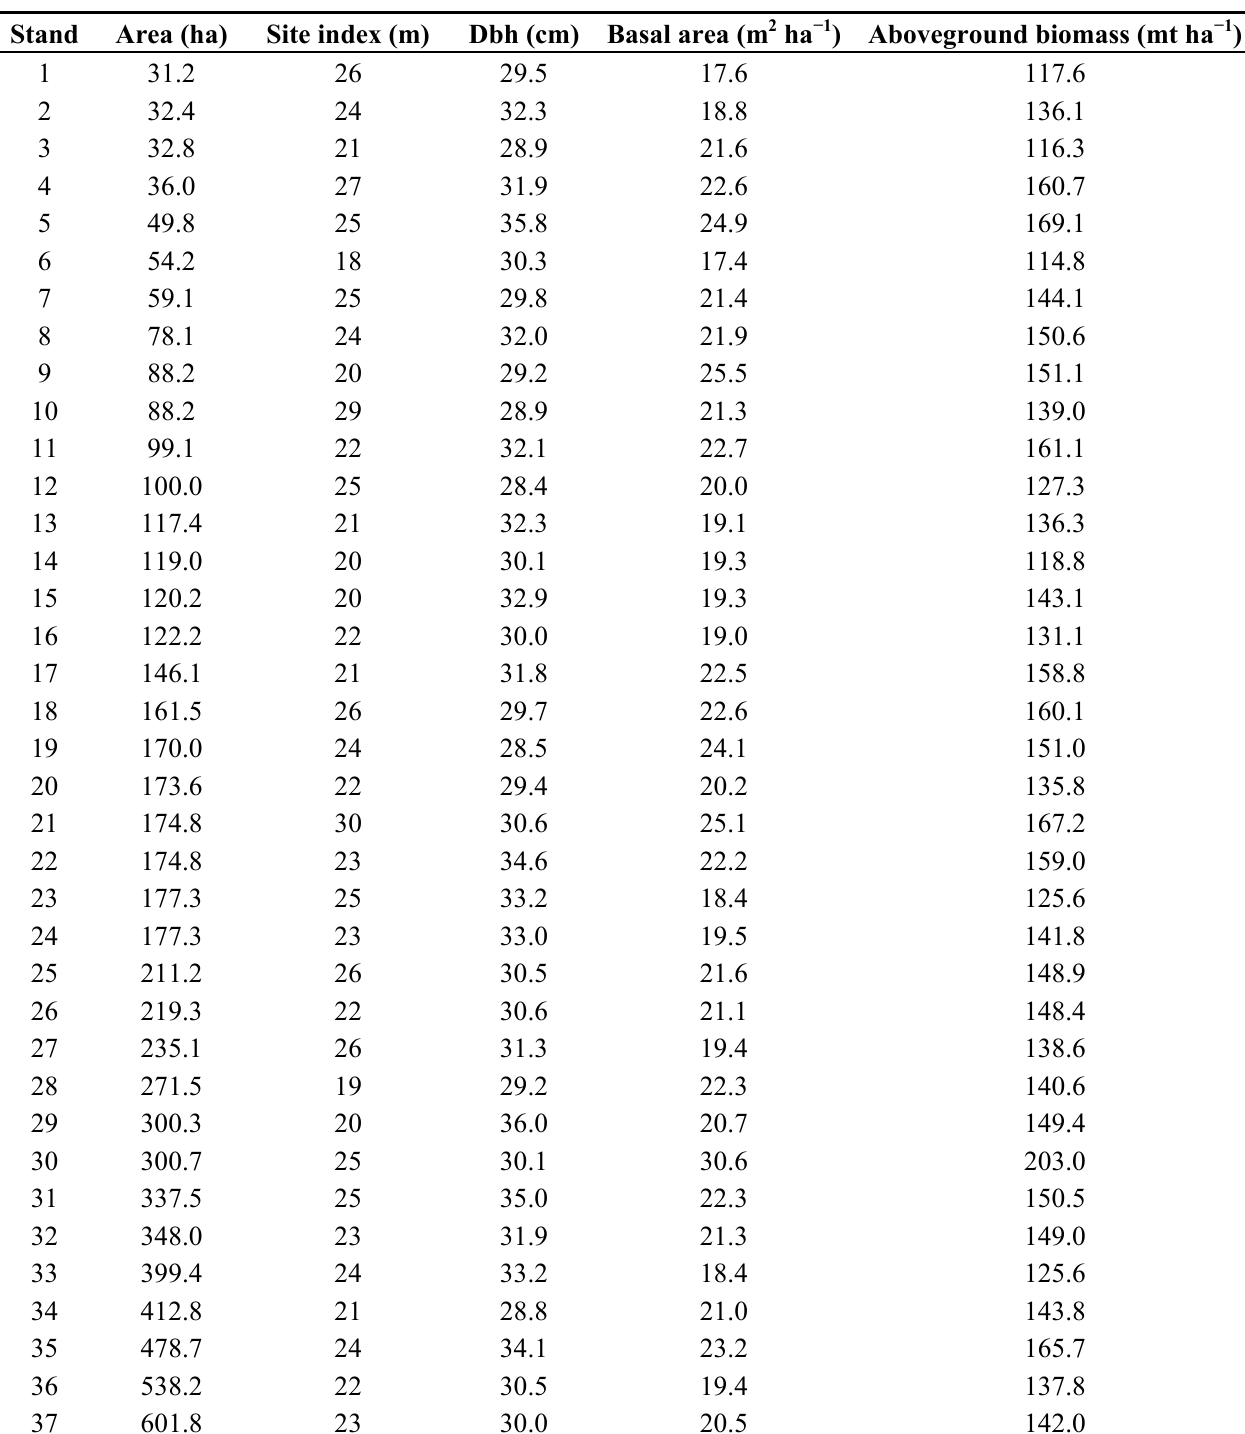
Table A1. Property characteristics for large tree (dbh > 19.1 cm) inventories used in double sample analysis. Includes stand area, mean site index, mean dbh, basal area, and aboveground